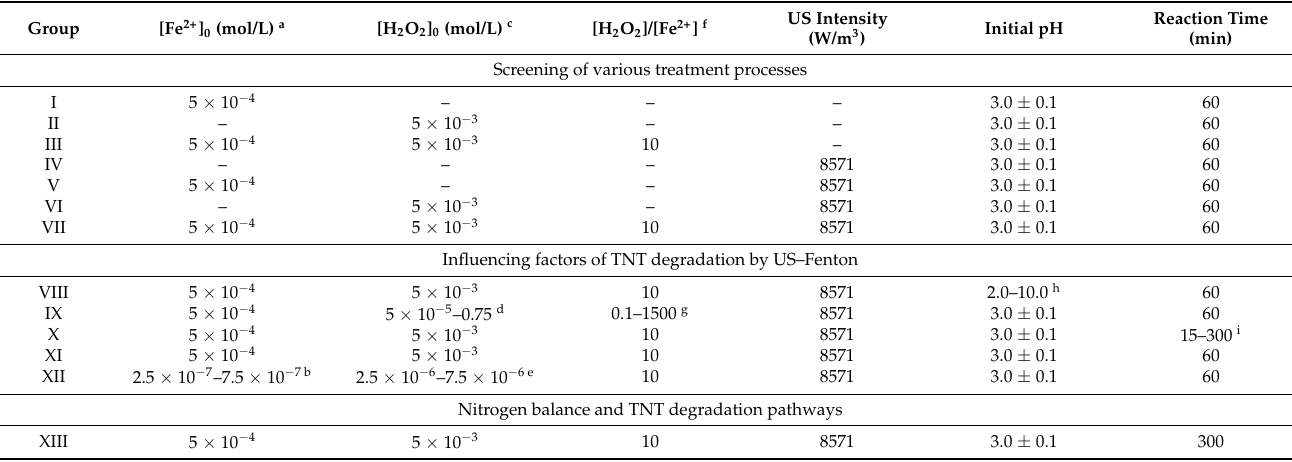
Table 1. Design of the